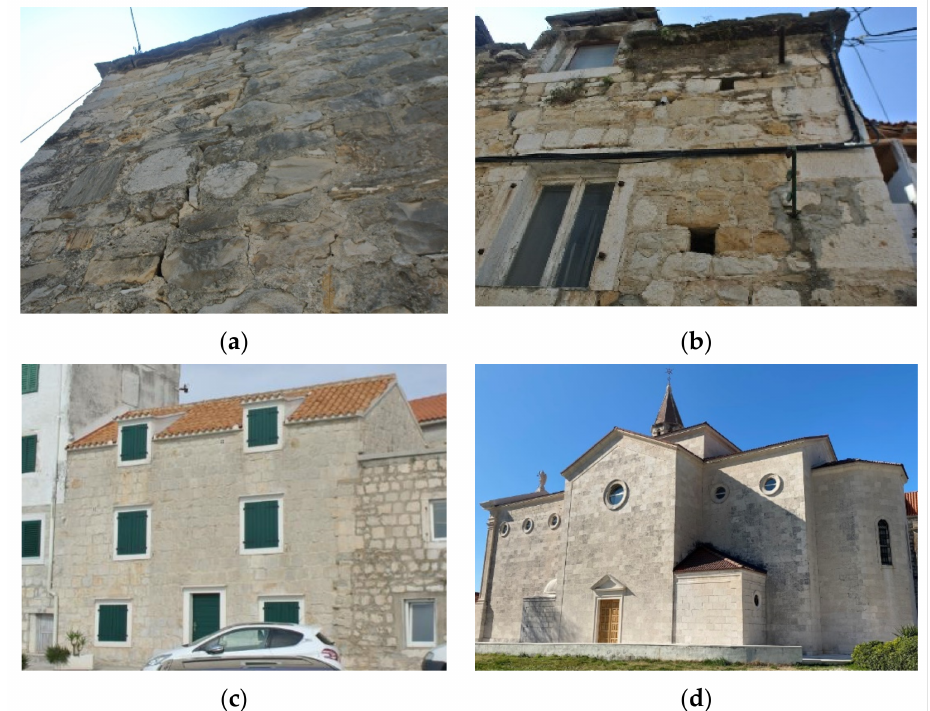
Figure 4. Examples of wall textures of stone masonry buildings: ( a ) non-squared roughly shaped stone masonry of various sizes arranged in chaotic manner; ( b ) wall composed of disorganized roughly shaped stones; ( c ) walls made of natural well-worked homogenous squared stones accurately executed; ( d ) walls of St. Mihovil church, composed of well-organized cut blocks.